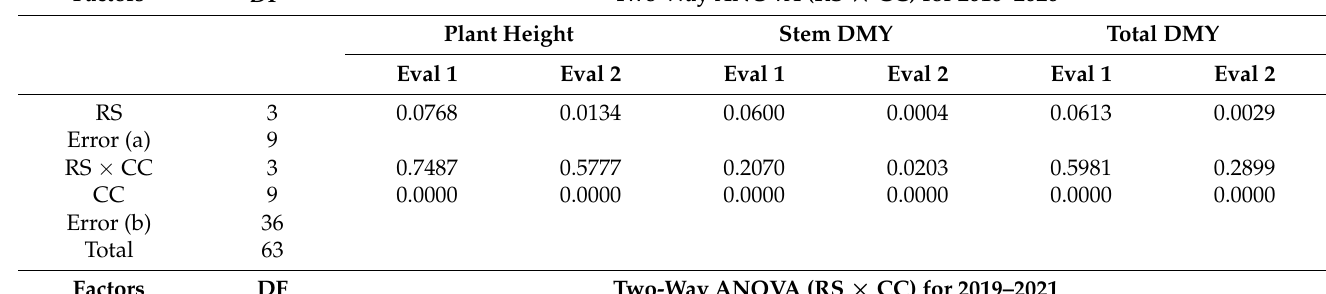
Table 5. The effects of sulla row spacing and cover crops on sulla plant height, stem DMY, and total analyzed separately for each growing cycle.